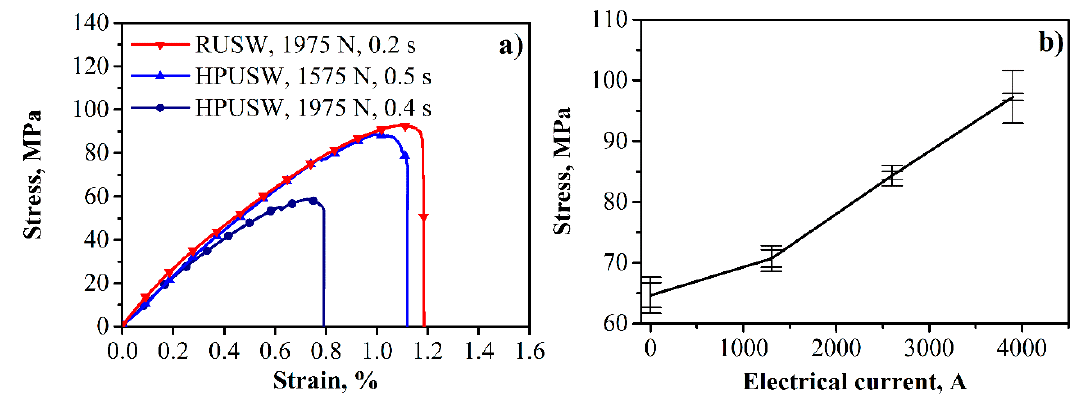
Figure 9. ( a ) The relationship between lap shear stress and strain; ( b ) the relationship between lap shear stress and electric current.